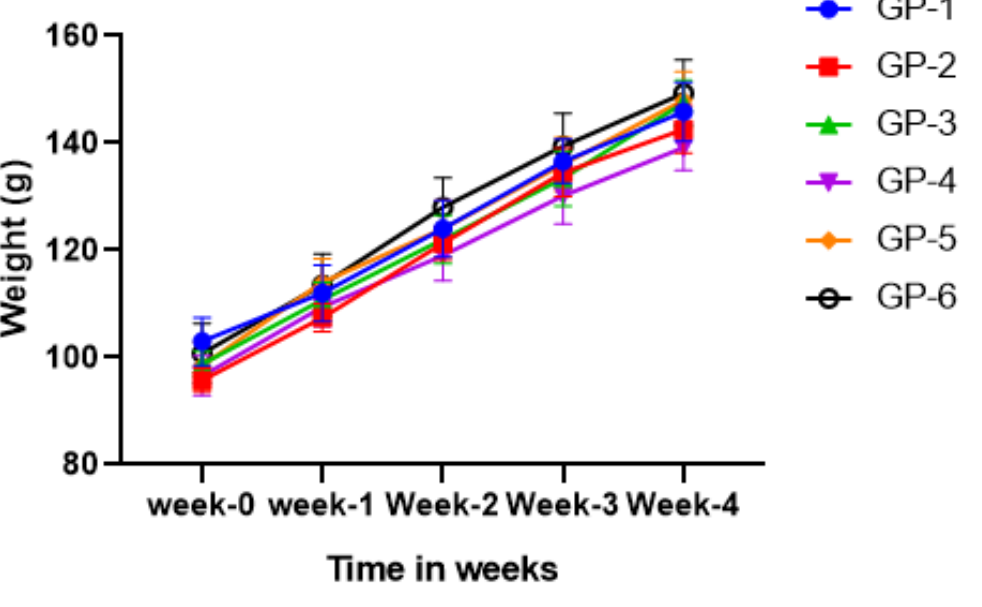
Figure 2. Effect of UV-exposed mushrooms and vitamin D on the growth of Wistar rats. There were no statistically significant differences between groups at any time. Each point represents the mean ± SD for n = 6.